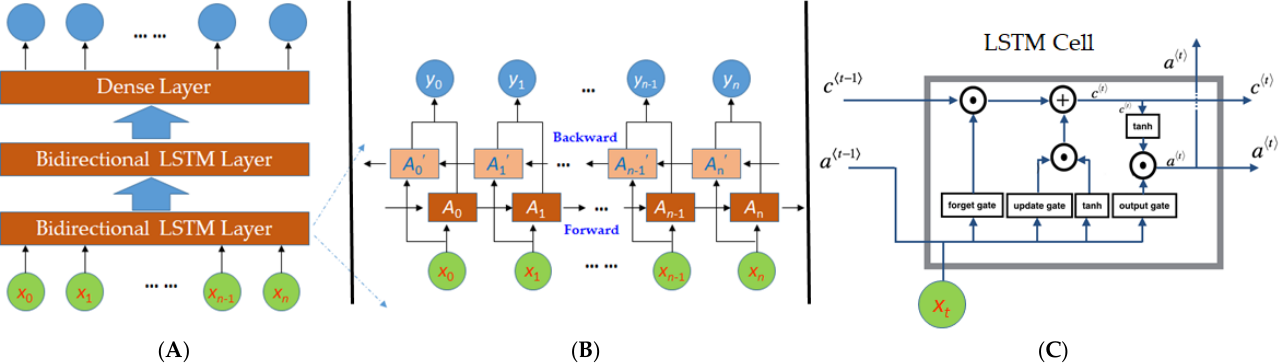
Figure 3. Neural network structure. ( A ) Overall network structure, ( B ) A bidirectional LSTM Layer, ( C ) An LSTM Cell.